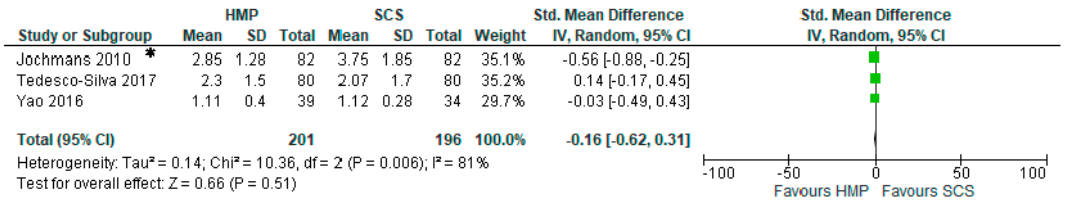
Figure 6. Comparison of one month post transplantation serum creatinine in kidneys preserved via HMP and SCS. In papers marked with “ * ”, mean and standard deviation were calculated using the method described by Wan 2014 [5].